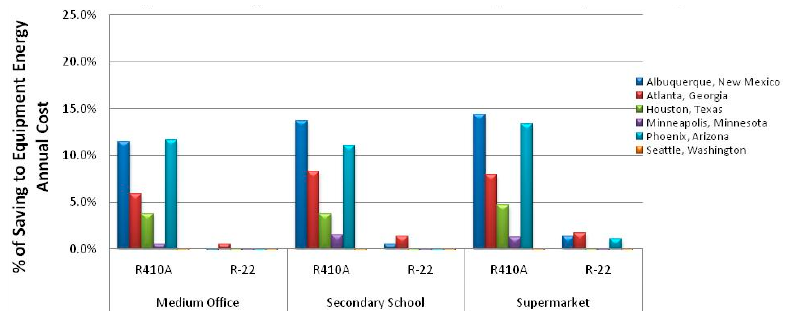
Figure 14. Percentage of energy savings due to pre-cooling relative to no pre-cooling at all ambient temperatures. Wet bulb efficiency = 0.9, equipment COP = 5.